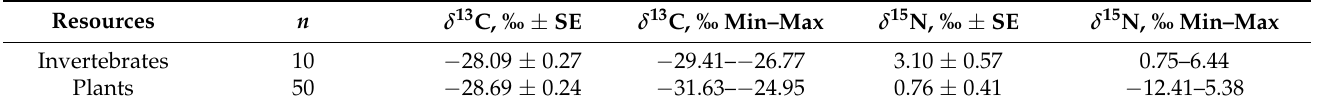
Table 2. Isotopic signatures of basal resources (invertebrates and plants, lichens not included) in the apple orchards.